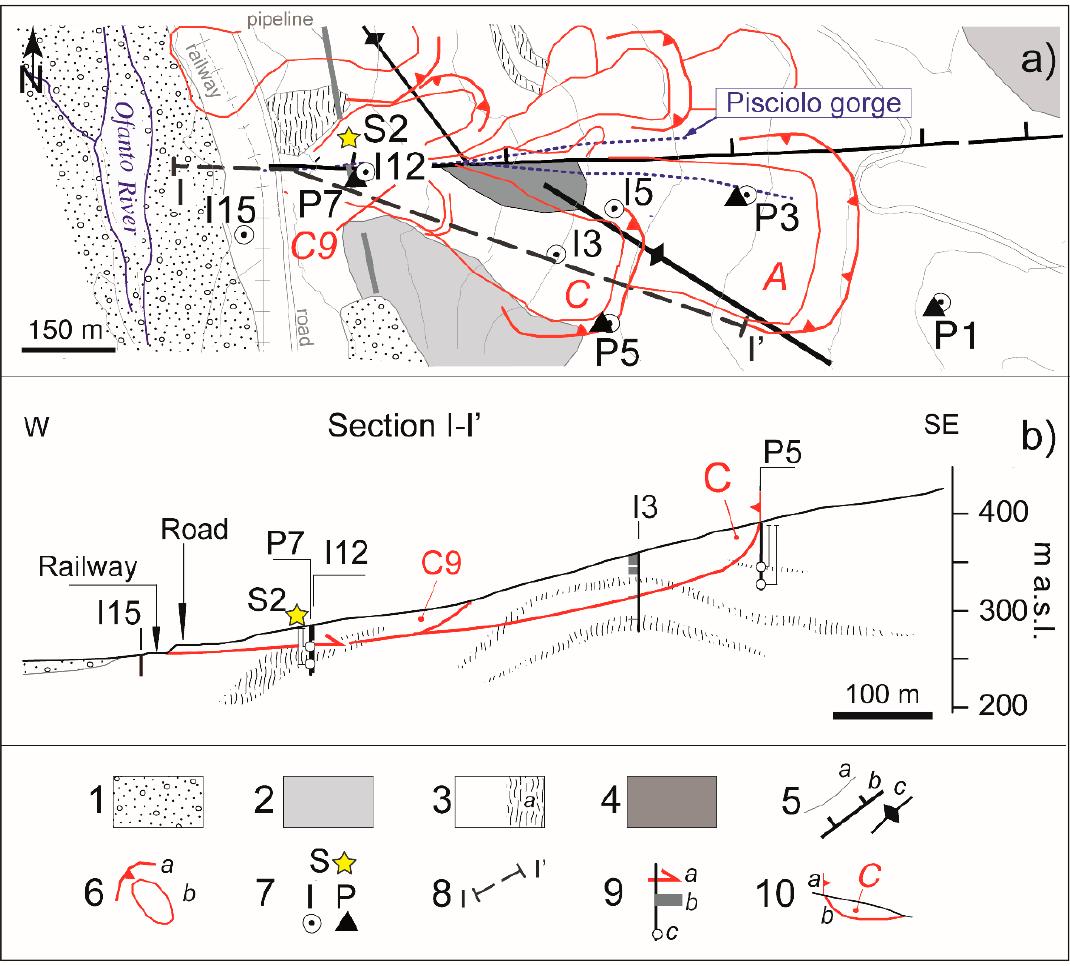
Figure 6. Geological map ( a ) and section ( b ) of the Pisciolo slope (modified from [40]). Key: (1) debris and alluvial deposits; (2) Numidian Flysch; (3) Paola Doce clays, and fractured rock inclusions (a); (4) Red Flysch; (5) stratigraphic contact (a), fault (b) and anticline axis (c); (6) landslide crown (a) and body (b); (7) borehole with piezometers (P), borehole with inclinometer (I), GPS sensor (S); (8) line of section; (9) inclinometer shear bending (a), disturbed soil (b) and piezometer cell with corresponding hydraulic heads (c); (10) labelled landslide: crown (a), slip surface (b).